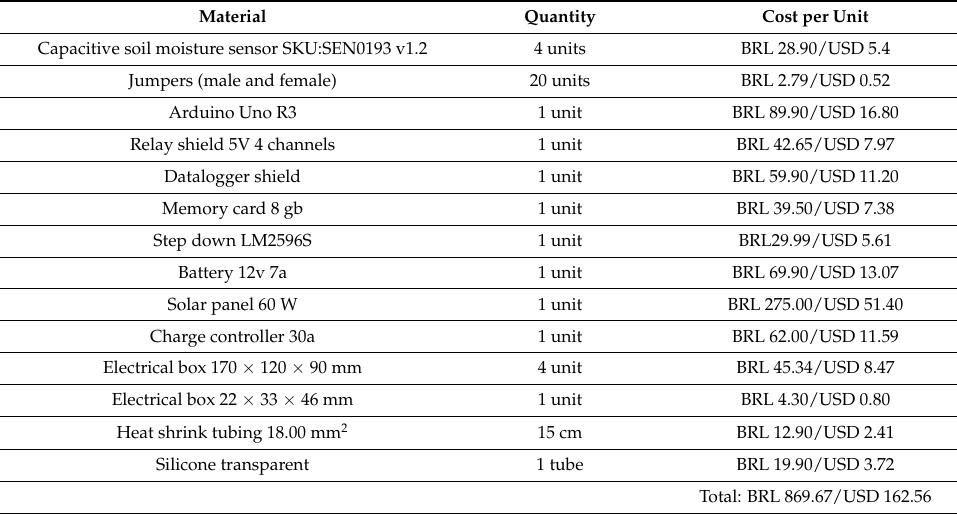
Table 3. Material used for building the wetting front monitoring station.